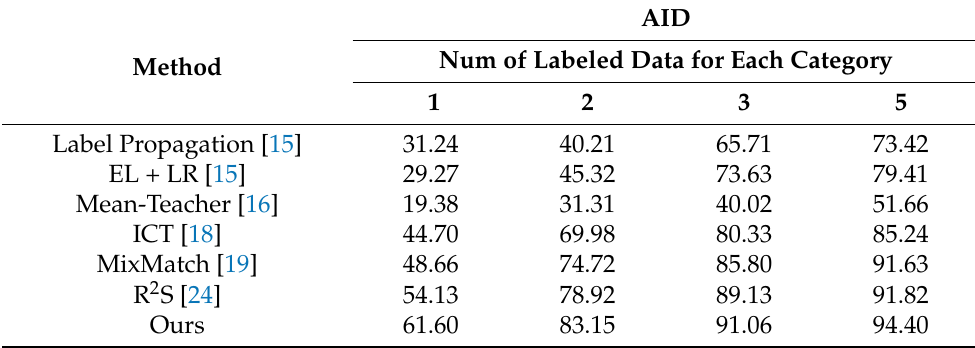
Table 3. Recognition accuracy (%) of label Propagation, EL + LR, Mean-teacher, ICT, MixMatch, R 2 S, and our proposed method with different labeled data for each category on AID